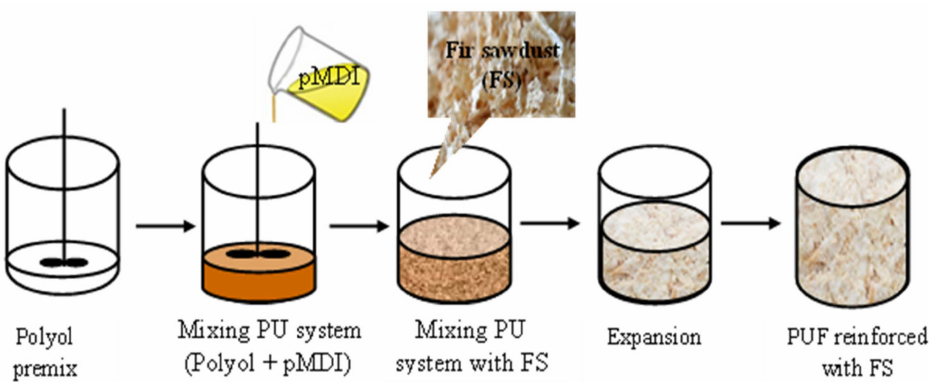
Figure 2. Schematic procedure of synthesis of FS reinforced